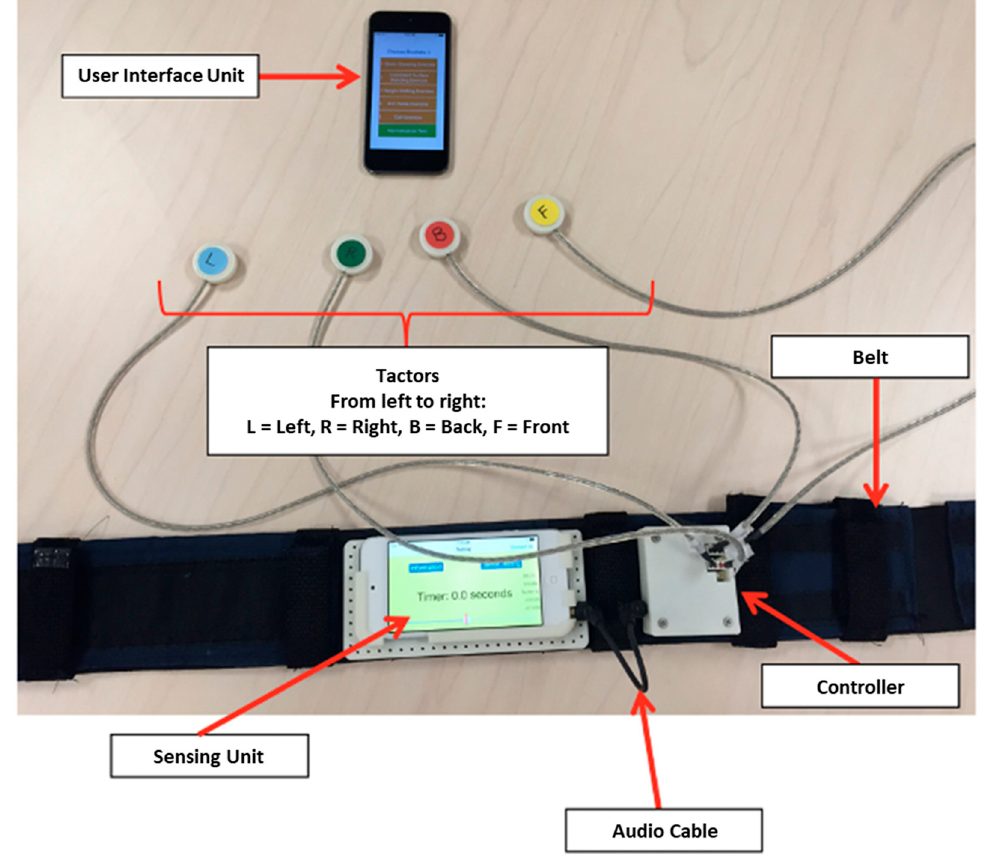
Figure 2. Smartphone-based balance